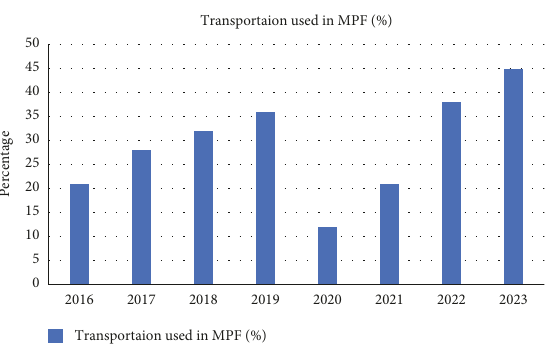
Figure 2: Use of logistic/transportation in MPF.